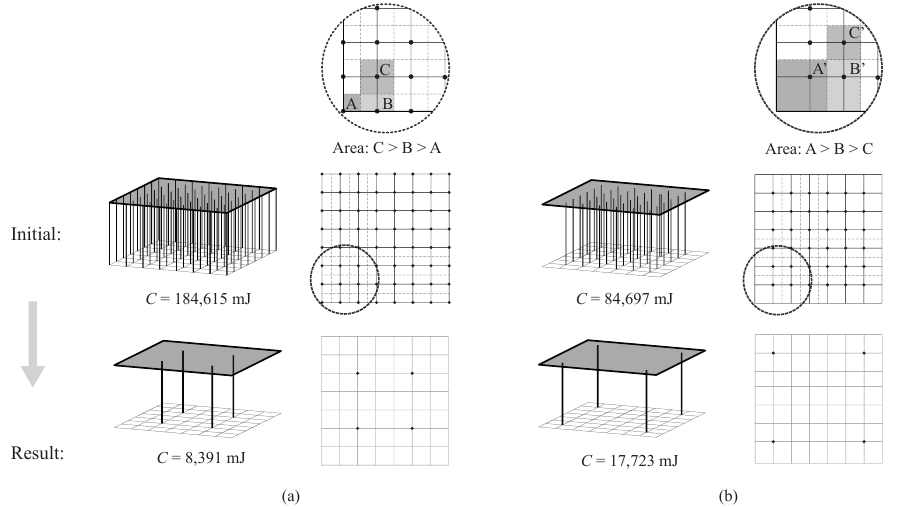
Figure 2. Designing column locations under a flat roof using ( a ) 8 × 8 and ( b ) 6 × 6 candi- date